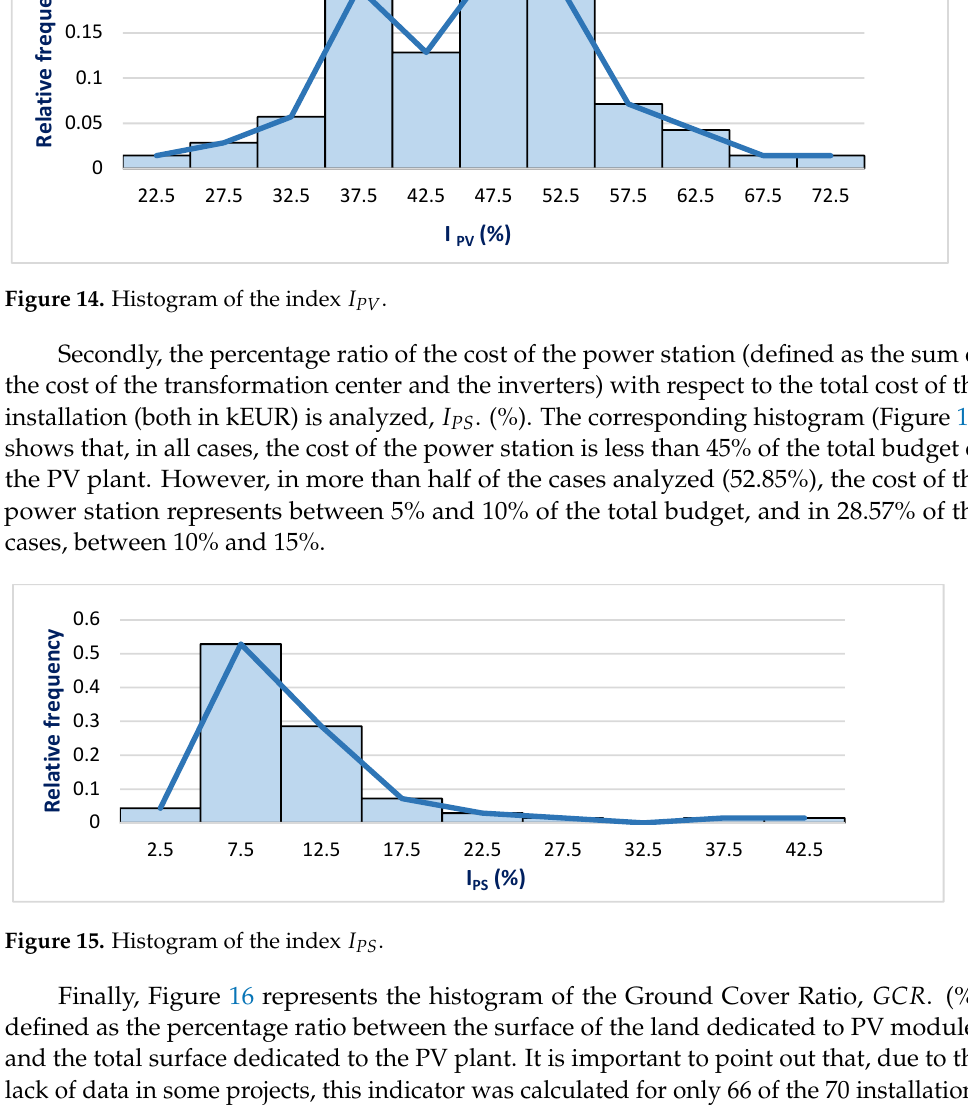
that varies between 45% and 85%.